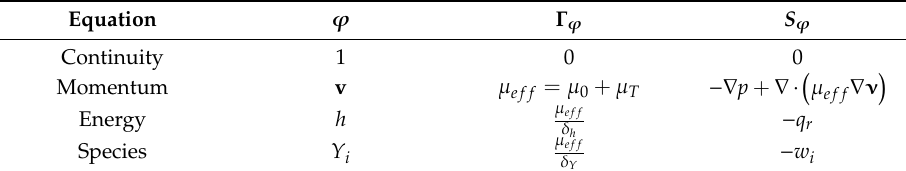
Table 3. General forms of turbulent transport